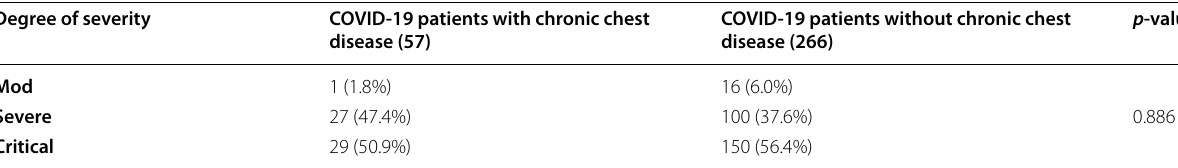
Table 6 Distribution of disease severity among the two groups Degree of severity COVID-19 patients with chronic chest disease (57)